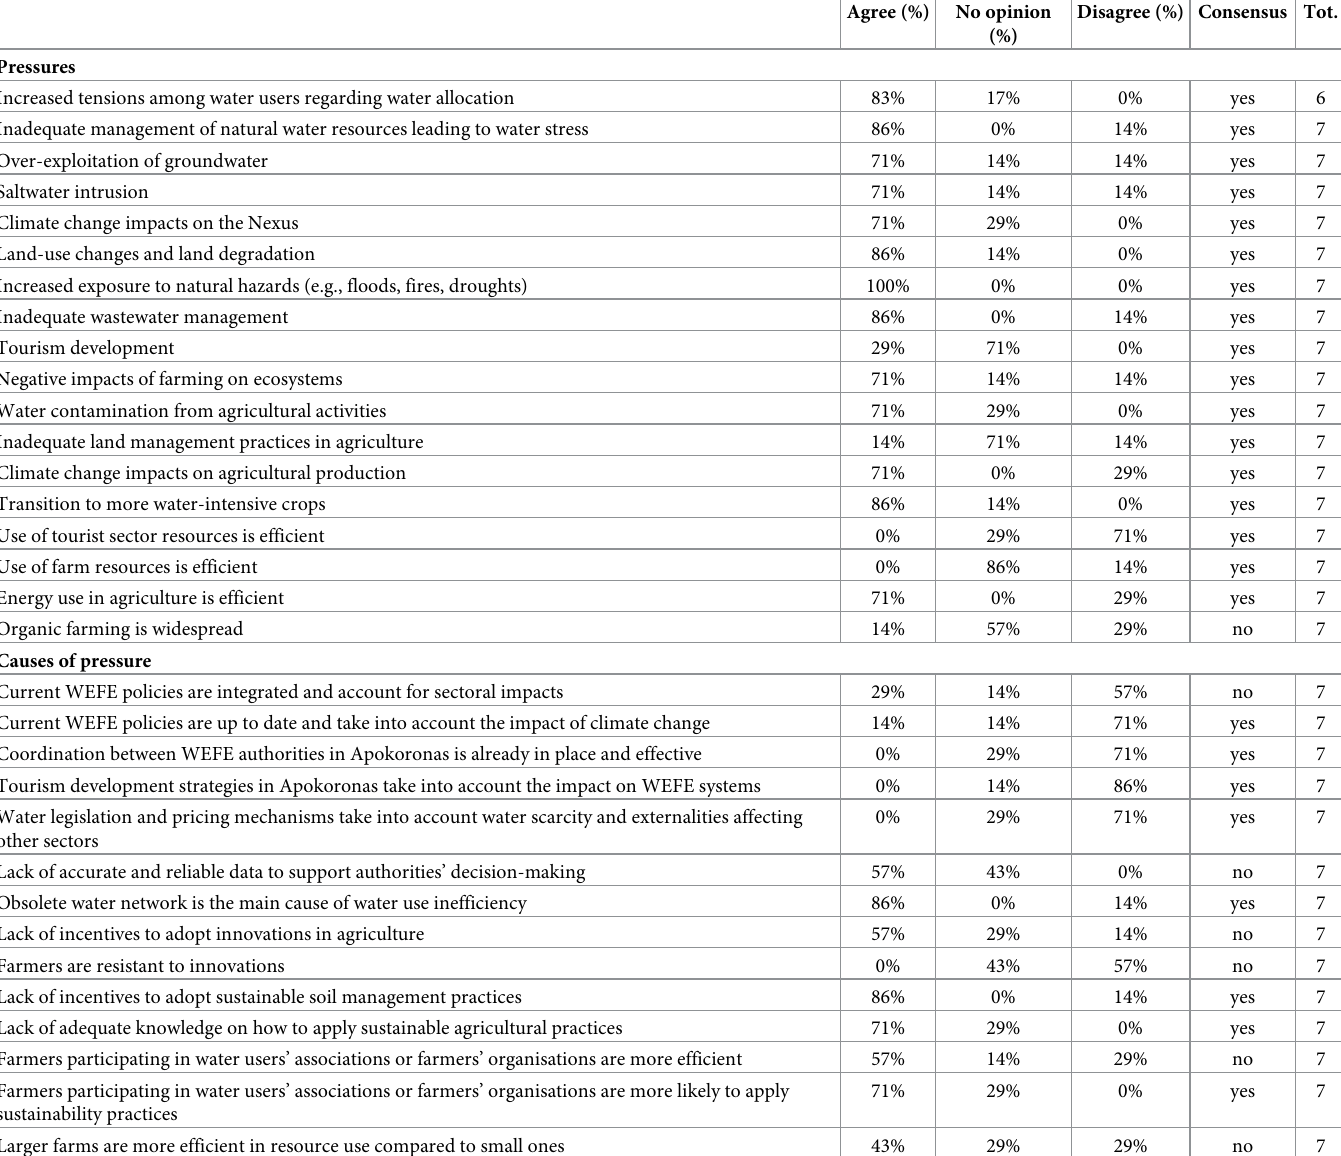
Table 1. Expert agreement on the pressures and causes of pressure on the WEFE Nexus in Apokoronas.